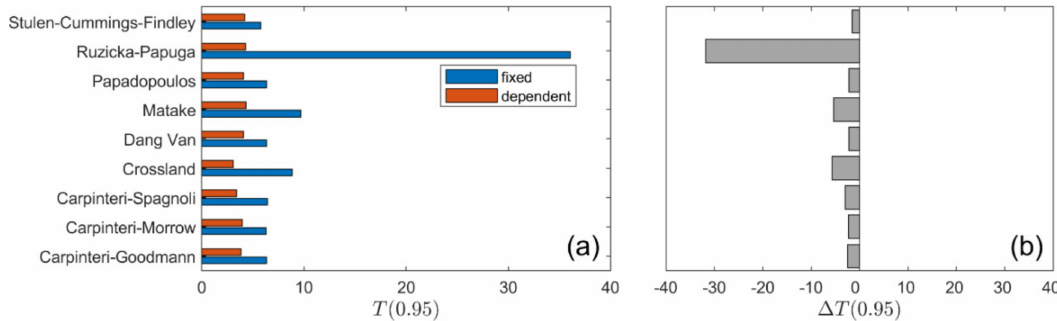
Figure 13. Summary comparison of calculation results for the analysed models under R = − 0.5 for 7075-T651 aluminium alloy: ( a ) fatigue scatter band and ( b ) change in the fatigue scatter band for all the analysed fatigue